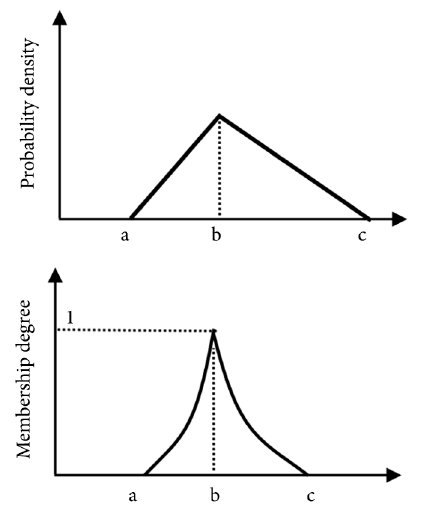
Figure 1. Transformation of the triangular distribution for the unit cost of One Wood Component (W)